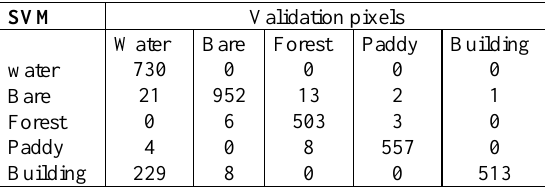
Table 3. Confusion matrix of SVM on Wuhan image